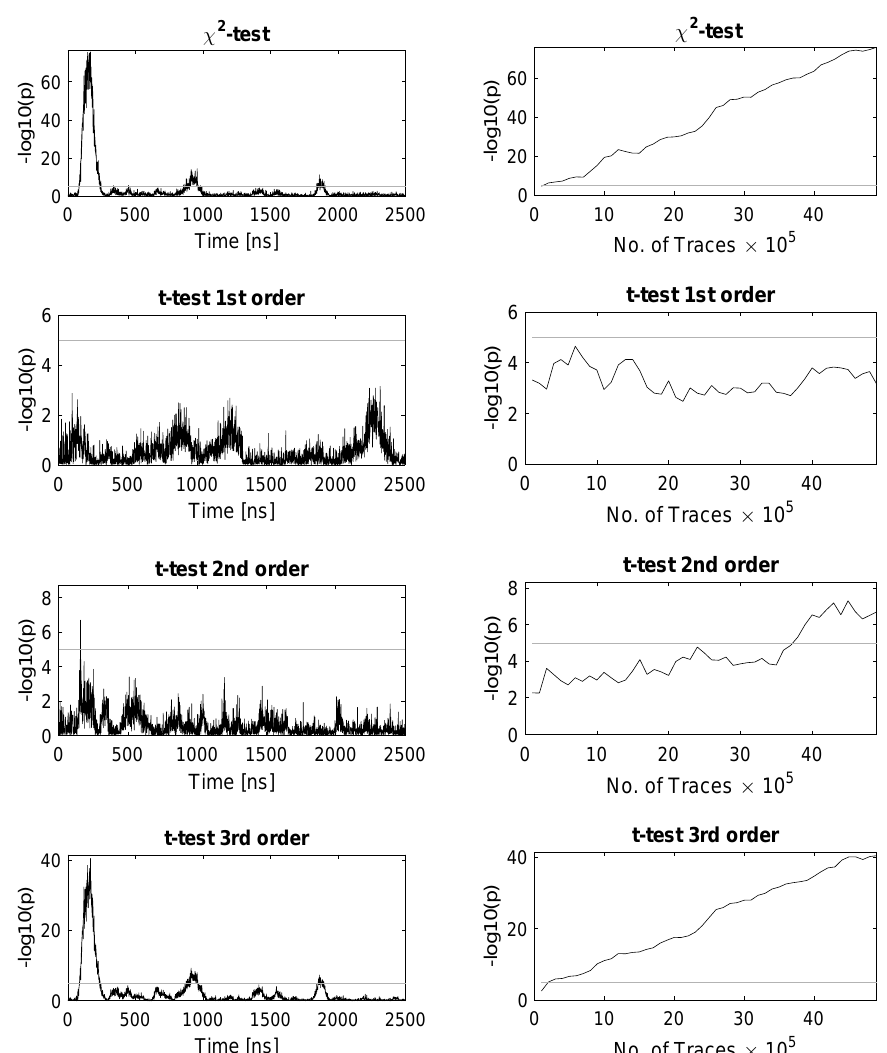
Figure 7: Results of the fixed-vs-random test using χ 2 -test, and 1st to 3rd order t -test, using 5,000,000